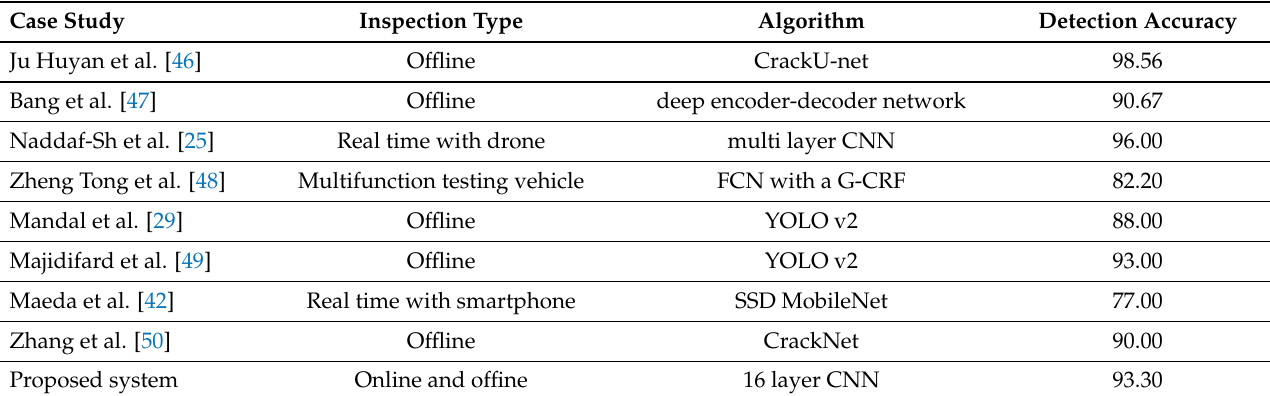
Table 7. Comparison with other detection schemes.